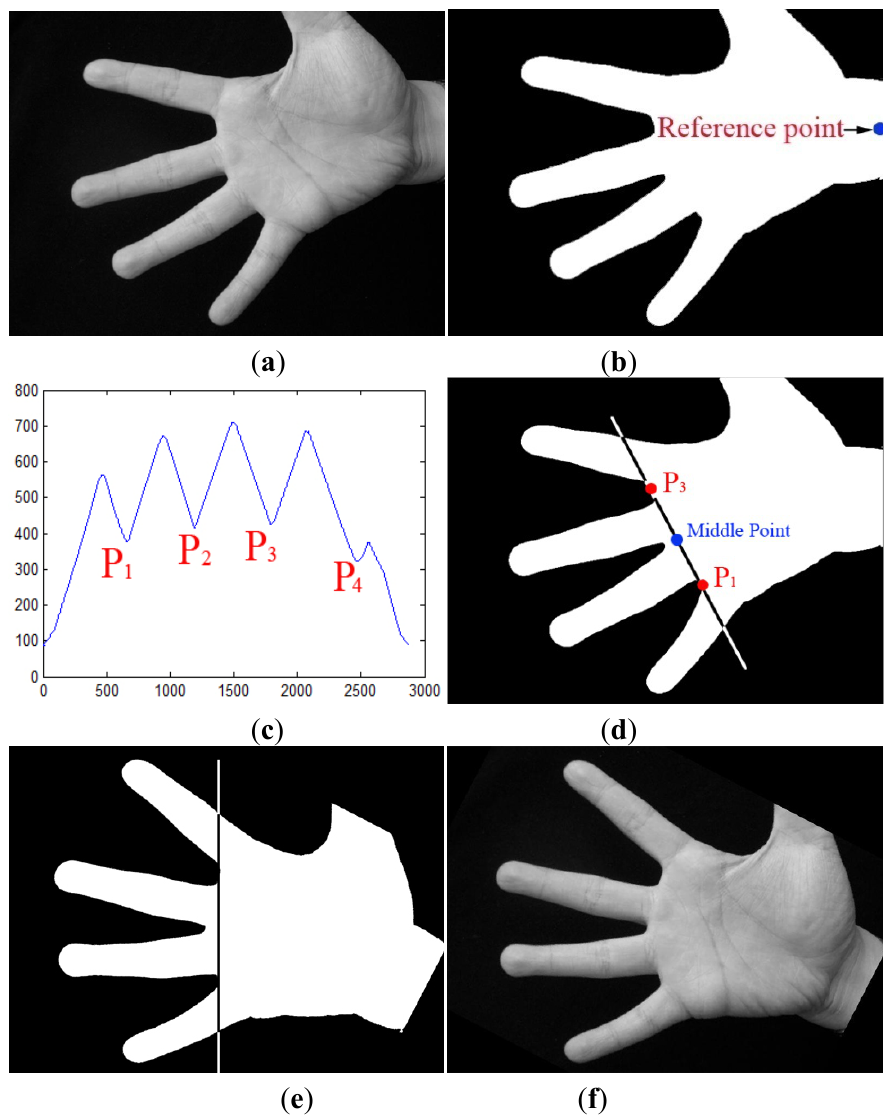
Figure 4. Main steps of the rotation normalization algorithm: ( a ) the gray palmprint image; ( b ) the binary palmprint image and reference point; ( c ) the radial distance function and four key points; ( d ) drawing a line segment P the binary image around the middle point of P normalized gray palmprint